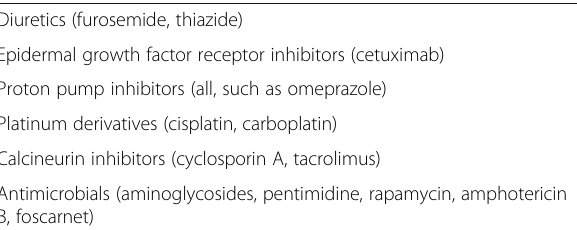
Table 5 Drugs associated with hypomagnesemia Diuretics (furosemide, thiazide) Epidermal growth factor receptor inhibitors (cetuximab) Proton pump inhibitors (all, such as omeprazole) Platinum derivatives (cisplatin, carboplatin) Calcineurin inhibitors (cyclosporin A, tacrolimus) Antimicrobials (aminoglycosides, pentimidine, rapamycin, amphotericin B,